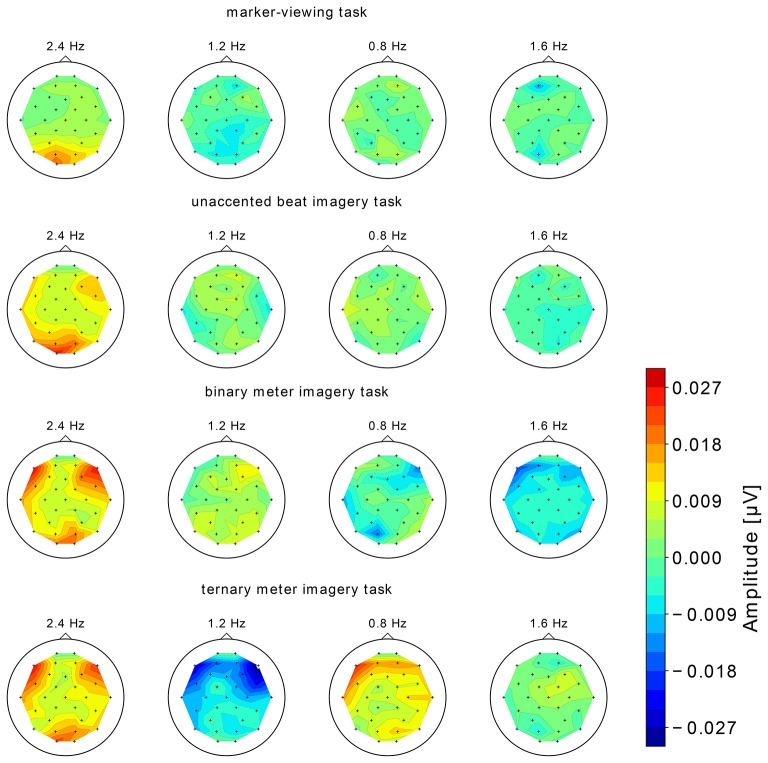
The topographical maps of EEG spectral amplitude at 0.8, 1.2, 1.6, and 2.4 Hz obtained in each of the four tasks. We show the group-level average of the EEG spectral amplitude.